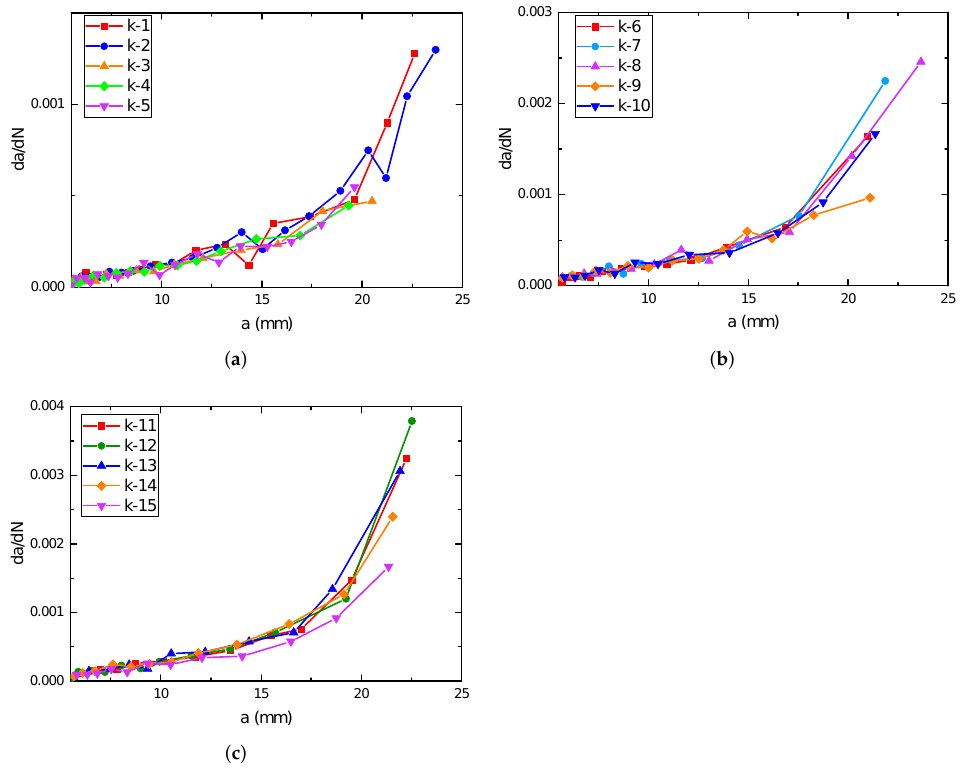
Figure 9. ( a ) a – da / dN curve of 15.20 kN. ( b ) a – da / dN curve of 18.24 kN. ( c ) a – da / dN curve of 19.76 kN.